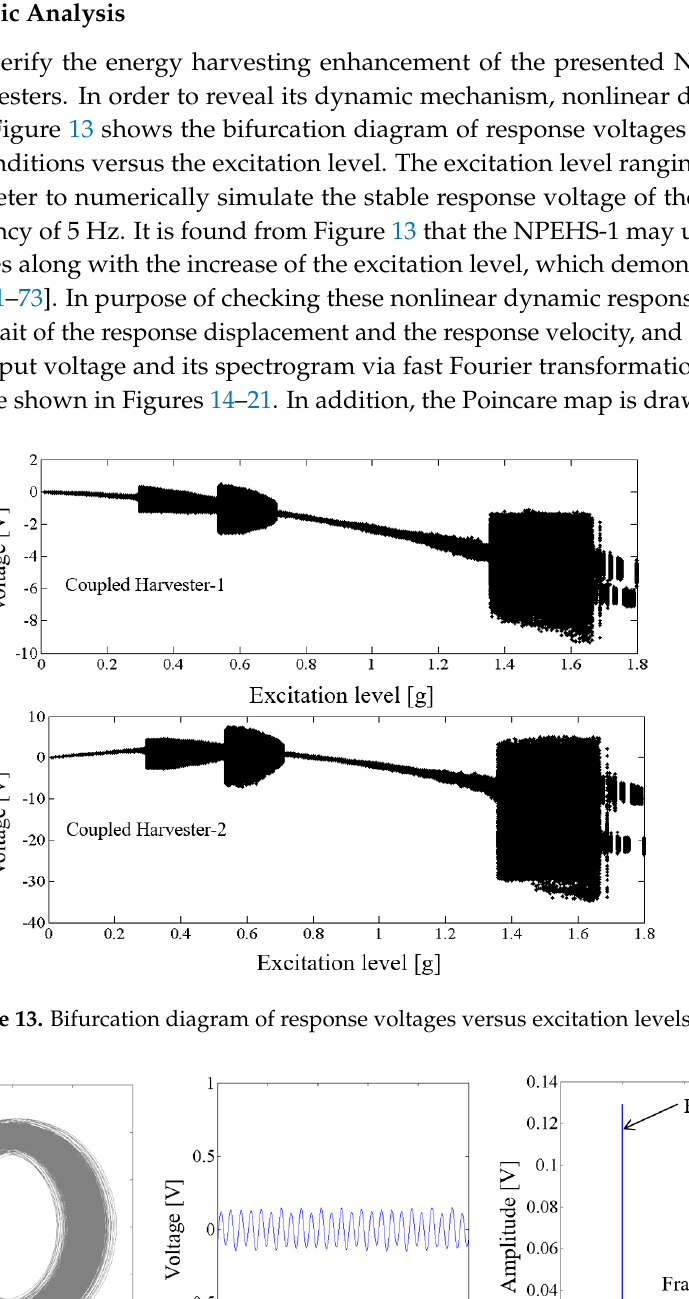
Figure 12. Output power area ratio of the NPEHS-2 versus load resistance.